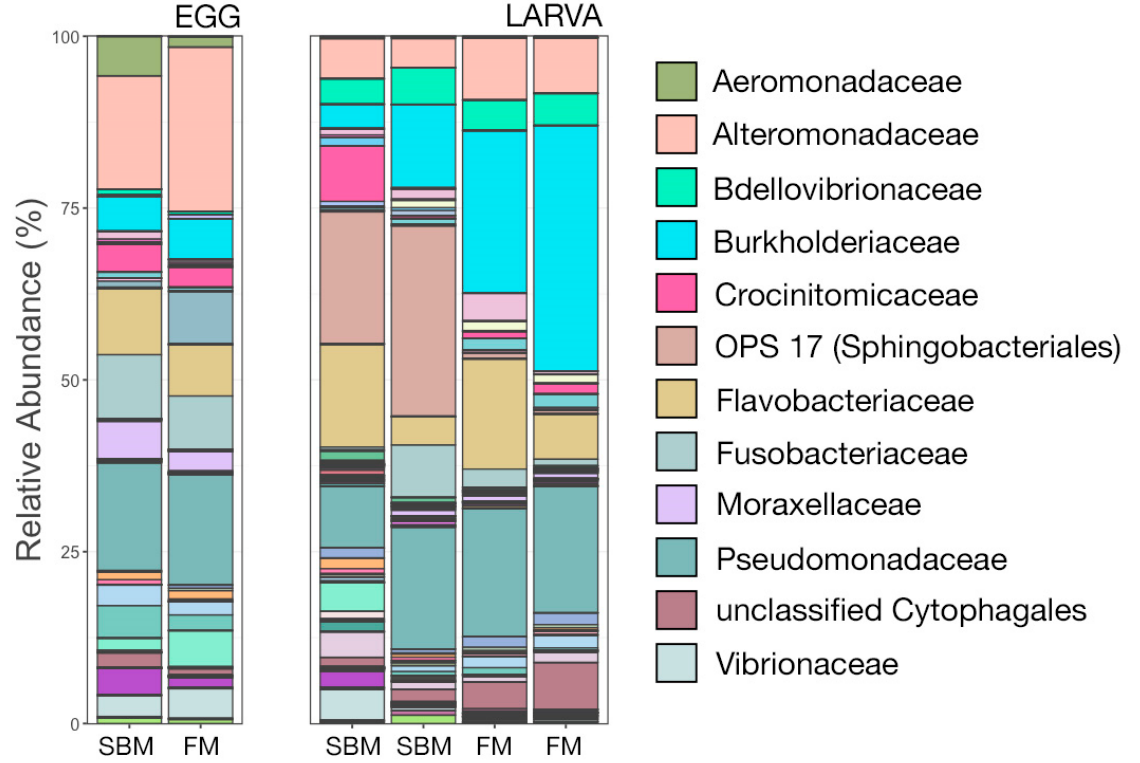
Figure 3. Bar plots showing the relative abundance of microbial families within egg samples and from larval samples (3 dph) obtained from spawning SBM-fed or FM-fed broodstock. Abundances were normalized to the total number of ASVs within each sample. The twelve most abundant families across all samples are displayed in the legend. Abbreviations: dph, days post hatch; FM, fishmeal; SBM, soybean meal.